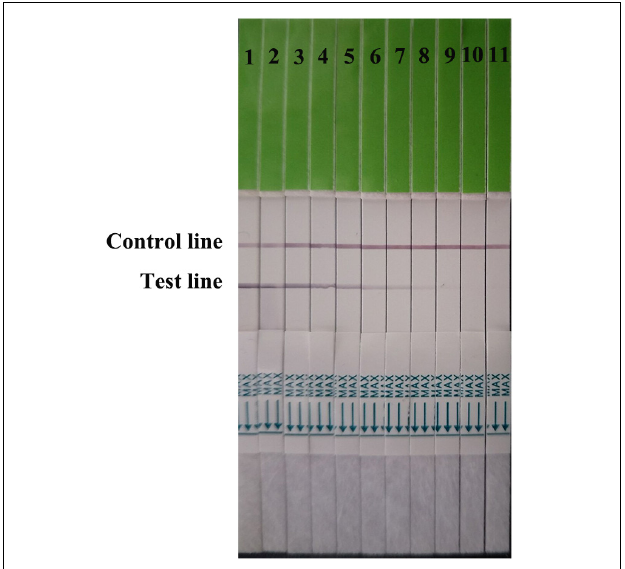
FIGURE 4 | Strip sensitivity. Serial dilutions of the positive sample ranging from 2 1 to 2 10 were used to determine the sensitivity of the strip. The titer of the positive sample was 2 8 . 1: the positive sample. 2–11: diluted ranging from 2 1 to 2 10 .